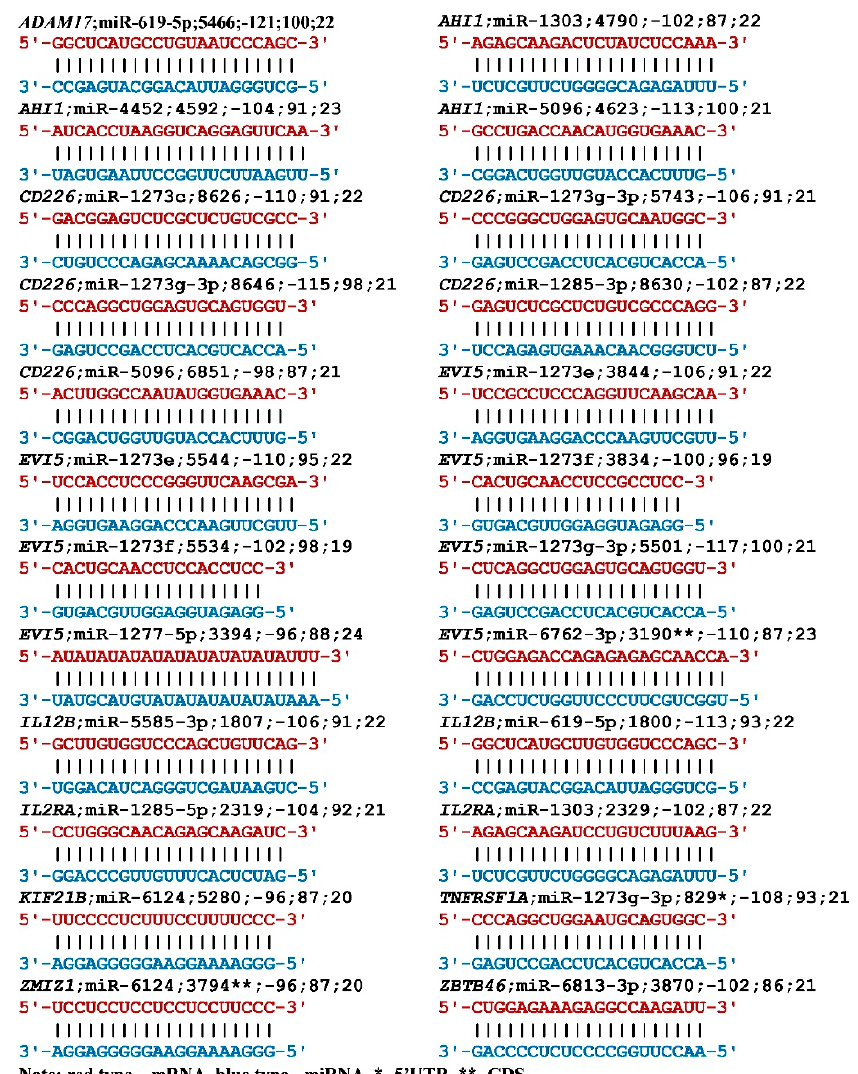
Figure 1. Schemes of miRNA (from miRBase) interaction with mRNAs of MS candidate genes.